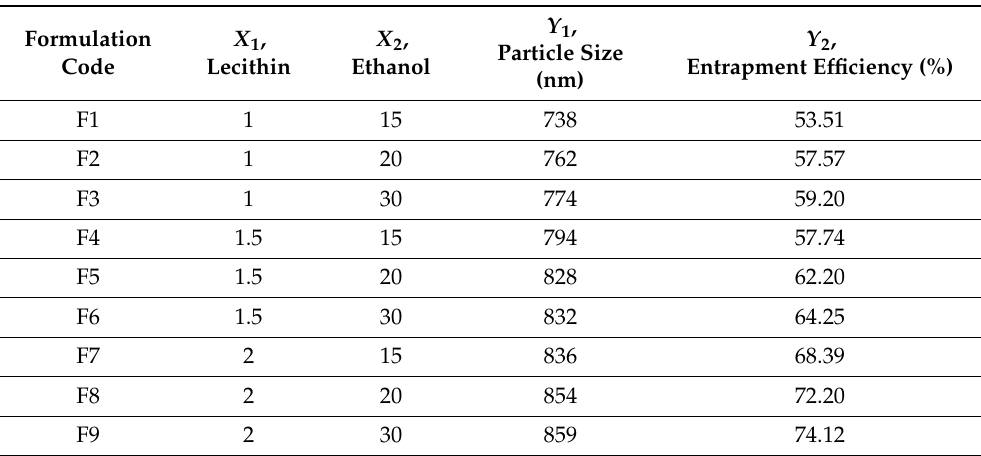
Table 2. Composition and characteristics of